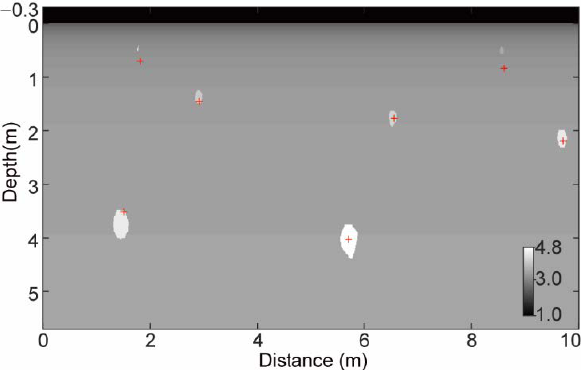
Figure 5. The scanning location of the rocks in the synthetic model. The red-cross indicates the scanning location of the diffractions.